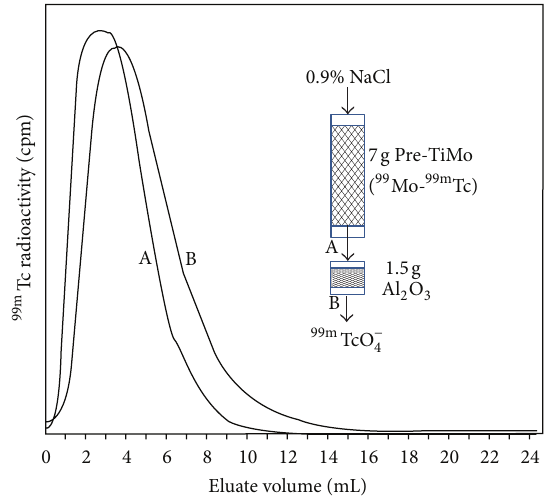
Figure 11: 99 m Tc elution profiles of Gelutec-A generator. A: the gen- erator column without coupling with alumina purification